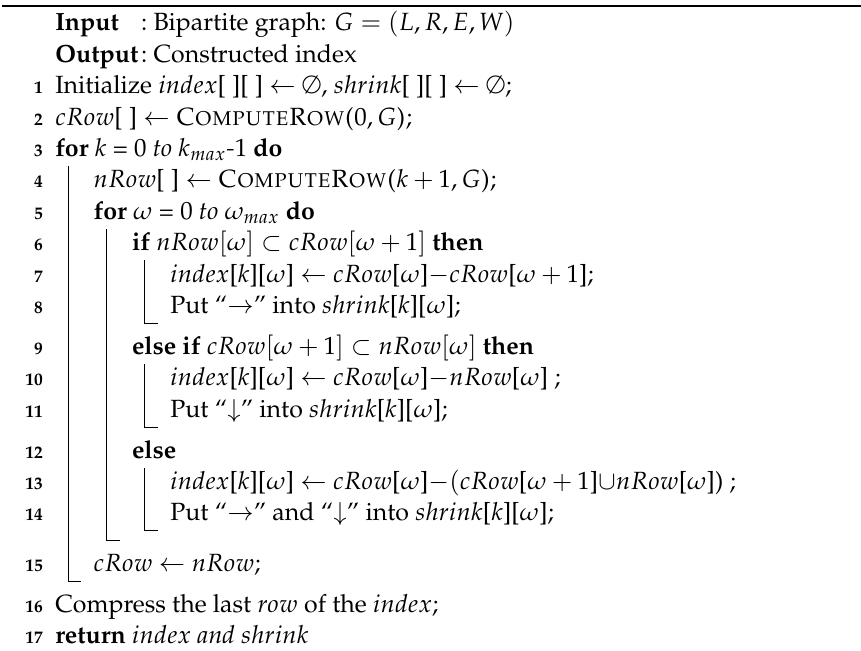
Algorithm 5 : U NION I NDEX C ONSTRUCTION A